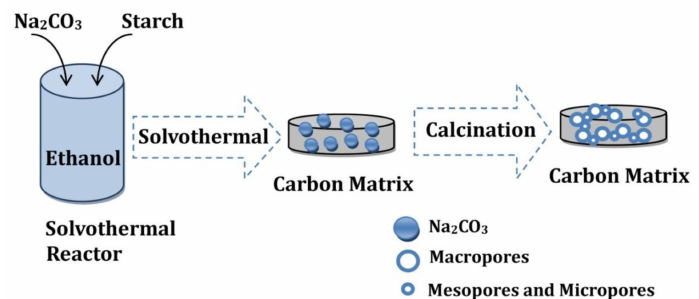
Figure 2. The synthesis steps and presumable mechanism for starch-derived carbon